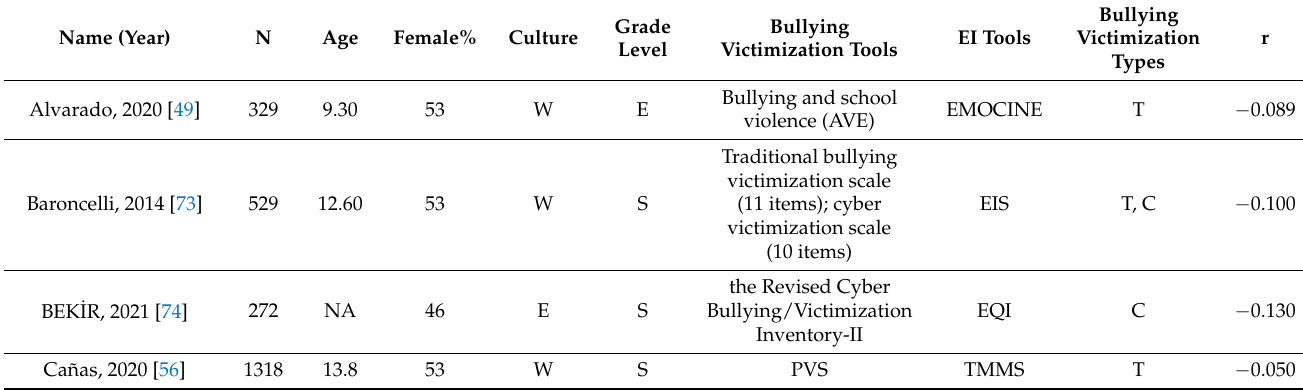
Table 1. The summary of the 24 studies included in the